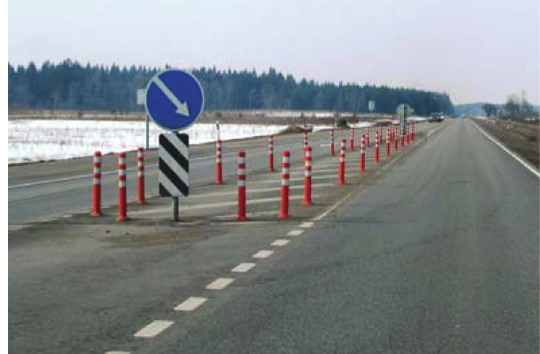
Fig. 5. Plastic reflective posts on the intersection of the road A16 Vilnius –